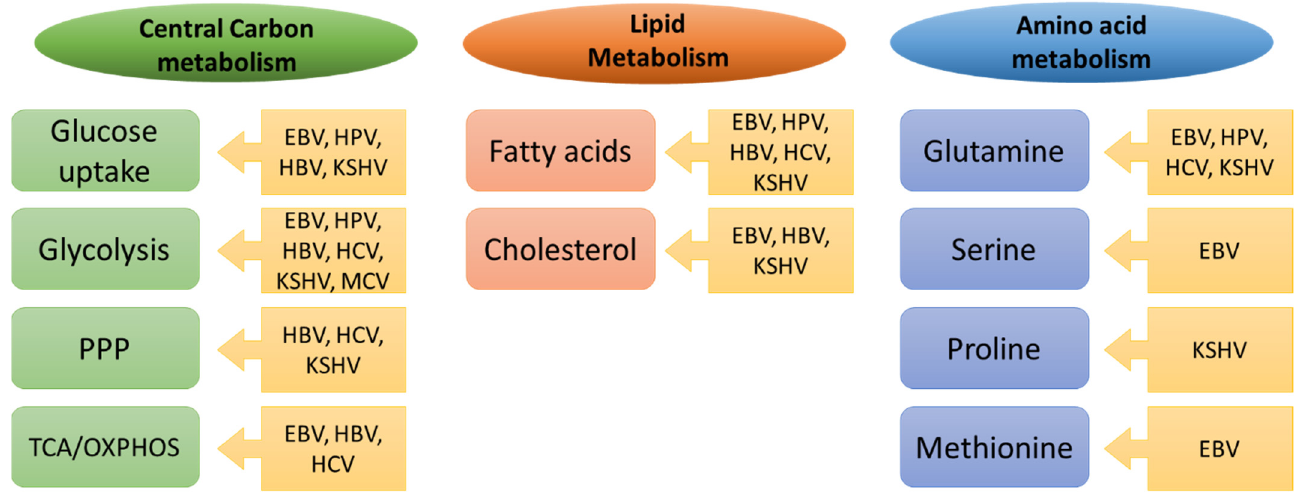
Figure 2. Common metabolic alterations in cancer and oncoviral infections. The key metabolic pathways altered in tumors and targeted by the indicated oncoviruses are depicted. See text for details.